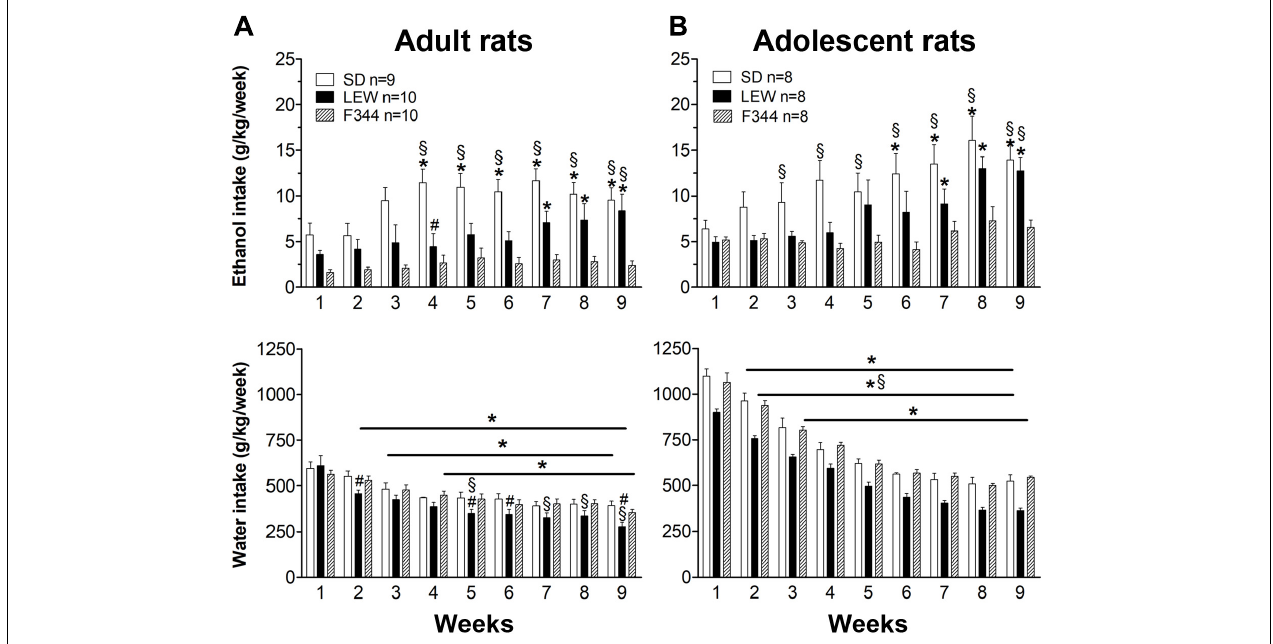
FIGURE 2 | Weekly pattern of ethanol and water intake. Weekly ethanol and water intake (g/kg/week) in the two age groups (A) adults and (B) adolescents of the three strains. Results are expressed as means ± SEM. * p < 0.05 vs. first week within each strain, # p < 0.05 vs. Sprague-Dawley (SD) strain, § p < 0.05 vs. Fischer 344 (F344) strain by two-way ANOVA for repeated measures followed by Tukey’s post hoc